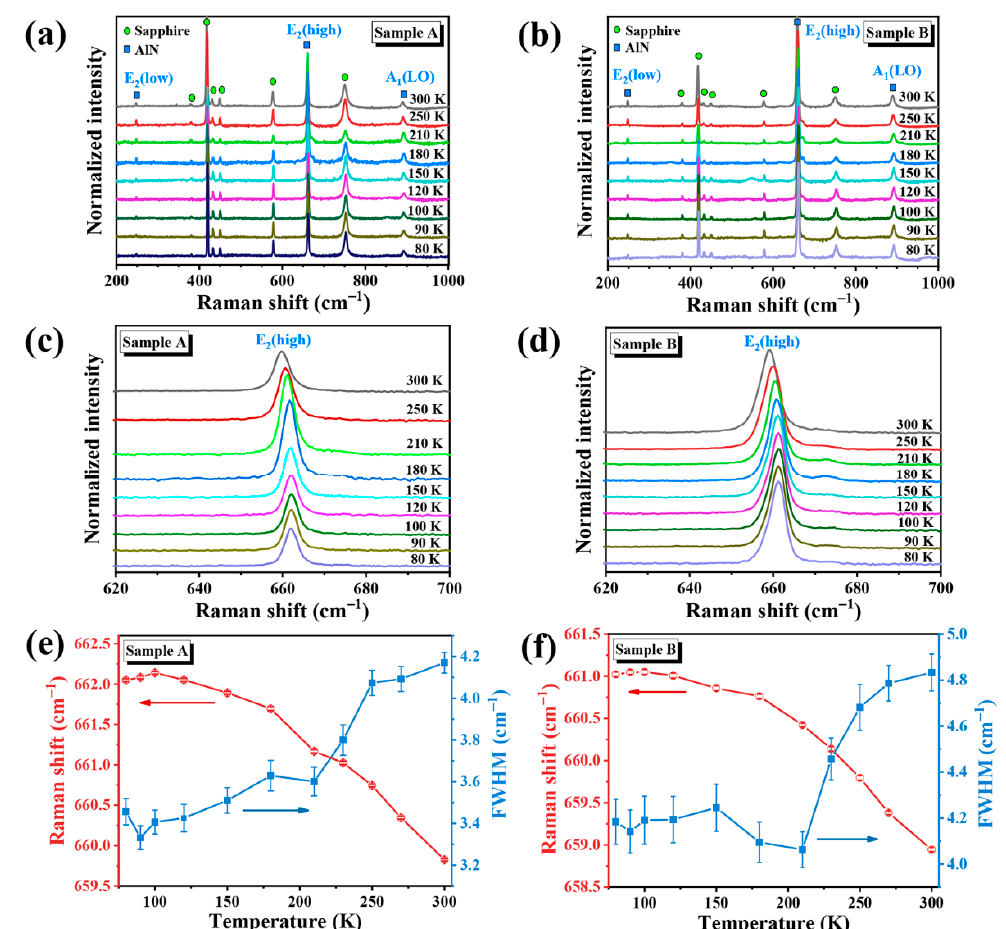
Figure 2. Raman spectra of AlN/sapphire films were taken at variable temperatures from 80 to 300 K by using 532 nm laser excitation, where ( a , b ) correspond to the sample A and sample B, respectively. The Raman shift of E 2 (high) phonon mode for ( c ) sample A and ( d ) sample B. Raman shift and full width at half maximum (FWHM) versus temperature of the E 2 (high) phonon mode for ( e ) sample A and ( f ) sample B in the range of 80 − 300 K.